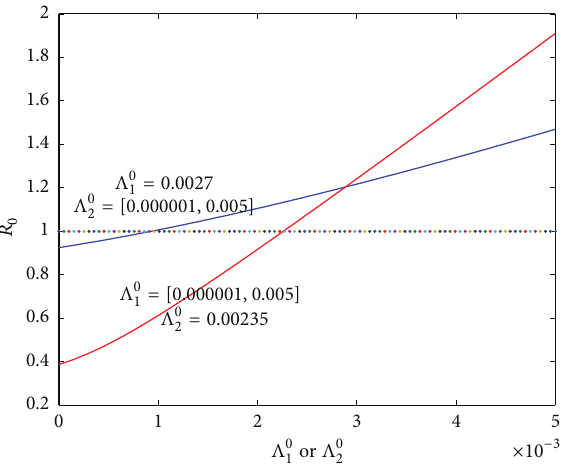
Figure 5: The graph shows the sensitivity of the basic reproduction number 𝑅 0 to the changes of Λ(𝑡) .